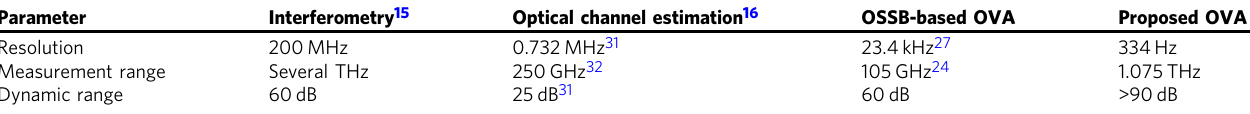
Table 1 Published results of typical optical vector analyzers